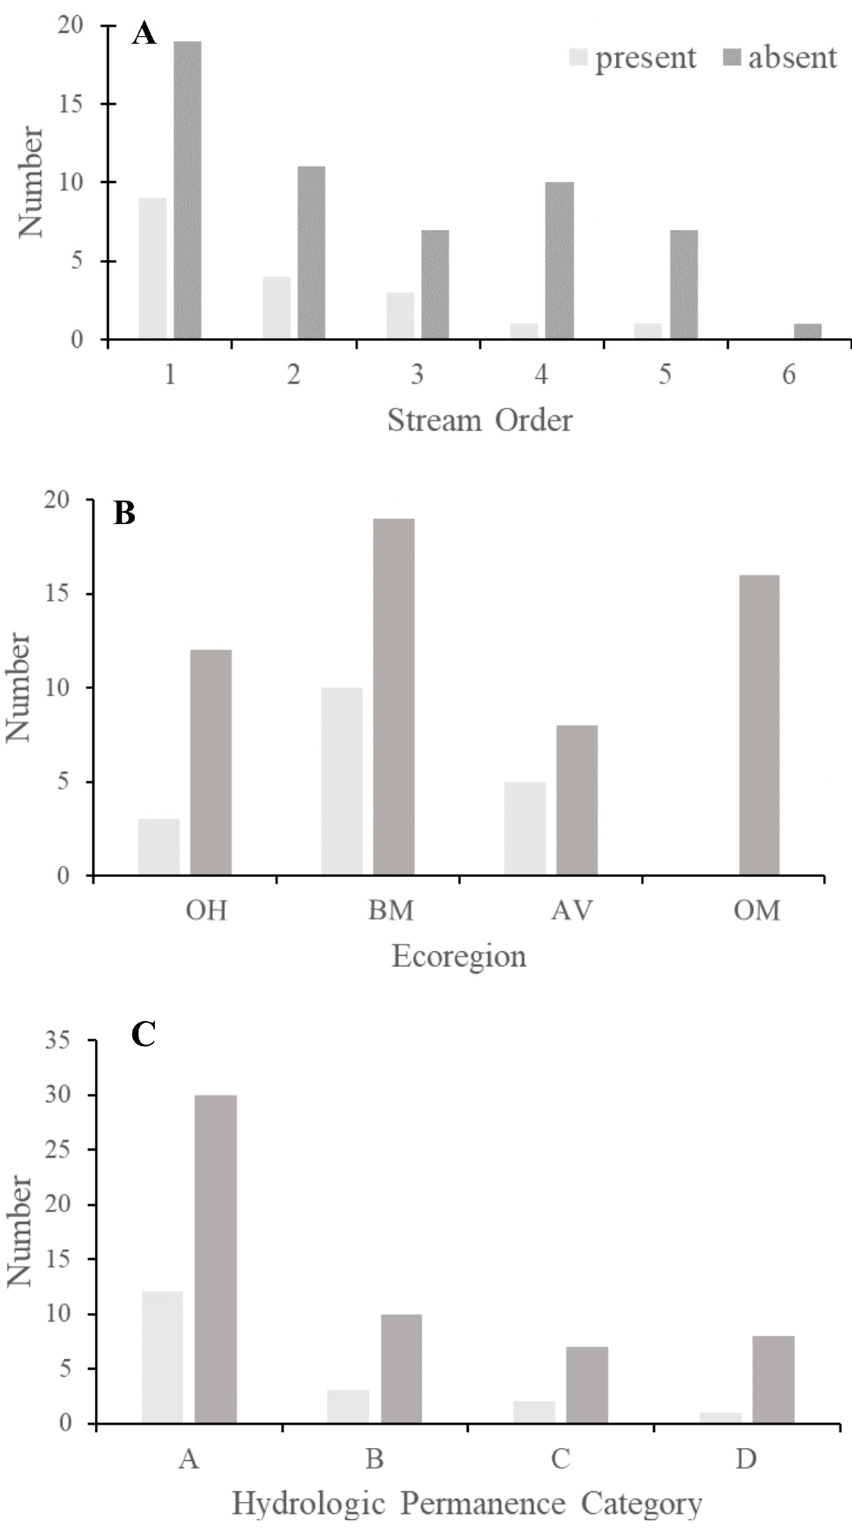
Figure 2. The distribution of A. mohri present and absent sites across stream orders ( A ), Omernik level III Ecoregions ( B ) of Ozark Highlands (OH) Boston Mountains (BM), Arkansas Valley (AV), and Ouachita Mountains (OM), and Hydrologic Permanence Categories ( C ); Poulton and Stewart, 1991).